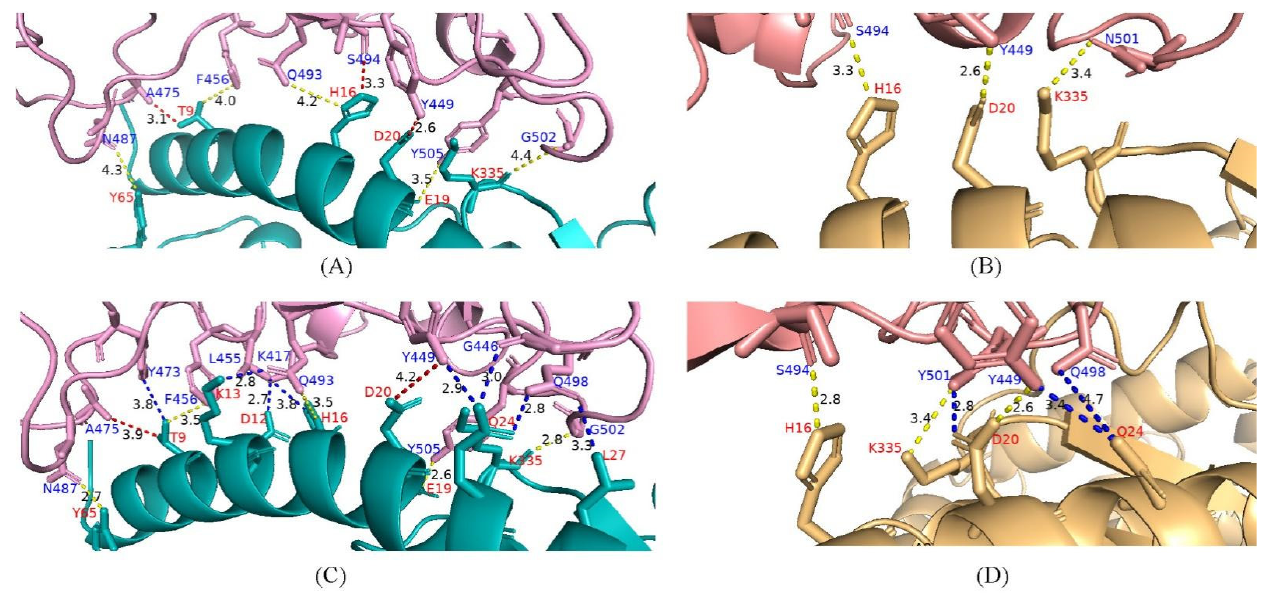
Figure 6. Interaction between Delta variant RBD and hACE2. ( A , B ) Bonding networks of L452-Q484 and N501 of Delta variant wild-type; ( C , D ) Bonding networks of mutants of 452R-484E and 501Y. The two mutants carrying those substitutions have potentially enhanced receptor binding capabilities of the RBD. Blue bonding stick, newly generated interactions. Red bonding stick, weakened interactions. Yellow bonding stick, increased or unchanged interactions. RBD, receptor-binding domain; hACE2, human angiotensin-converting enzyme 2.